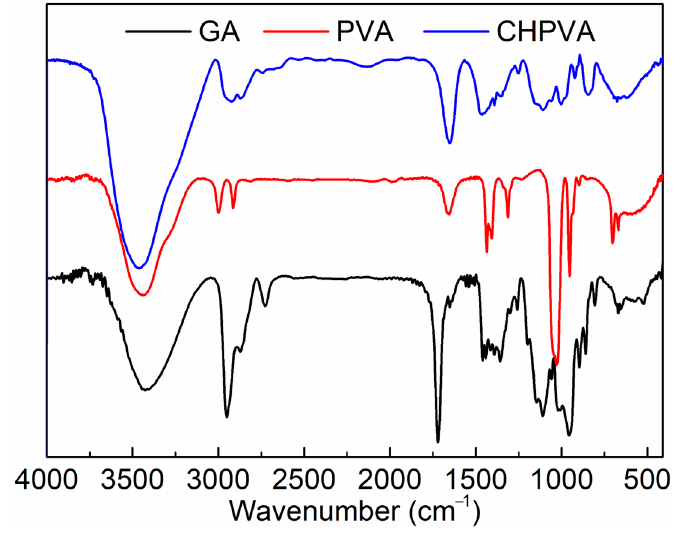
Figure 2. FTIR spectra of the GA, PVA, and CHPVA samples.